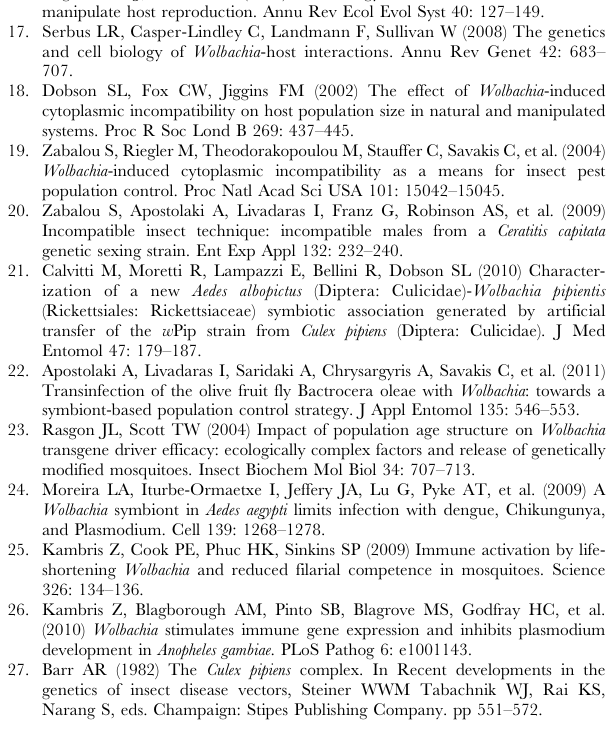
Figure S2 Genetic patterns of Culex pipiens lines and their Wolbachia strains. A, PCR-RFLP of the Cx. pipiens ace-2 gene digested by ScaI enzyme; B, PCR-RFLP of the Cx. pipiens Ester 2 gene digested by AvaII enzyme; C, PCR products of the Wolbachia ank2 gene. The LR[ w Pip(Is)] line carries the LR nuclear background and the w Pip(Is) infection; LR-TC is an uninfected mosquito line. M, molecular weight markers; kb, kilo bases. Table S1 Genes and primers of Wolbachia and Culex pipiens